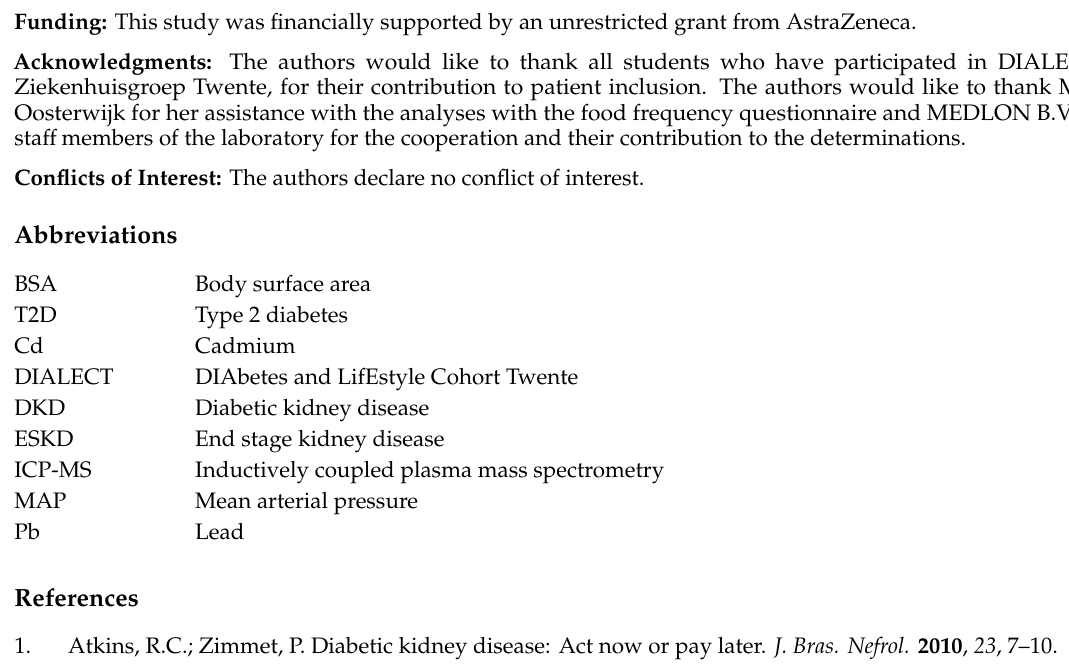
Table S1: Perkin Elmer Nexion300 × ICP–MS instrumentation, Table S2: Overview of food items included in each food category, Table S3: Daily amounts of dietary intake, Table S4: Multivariate logistic regression between Cd and Pb and albumin / creatinine ratio. Table S5: Multivariate logistic regression on the association between Cd and Pb and albuminuria and reduced creatinine